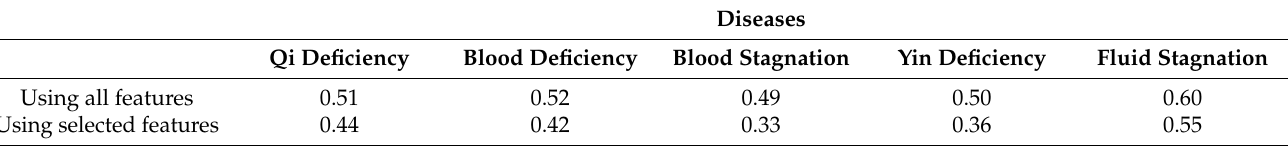
Table 4. Mean absolute error between the correct value assigned by the Kampo doctors and the estimated value by SVR before and after feature selection for each disease.